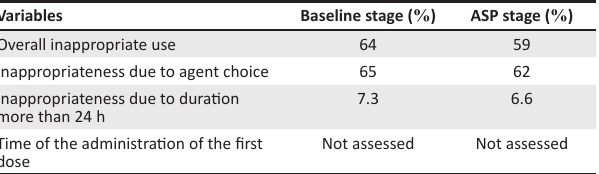
TABLE 3: Appropriateness of peri-operative antibiotic prophylaxis.